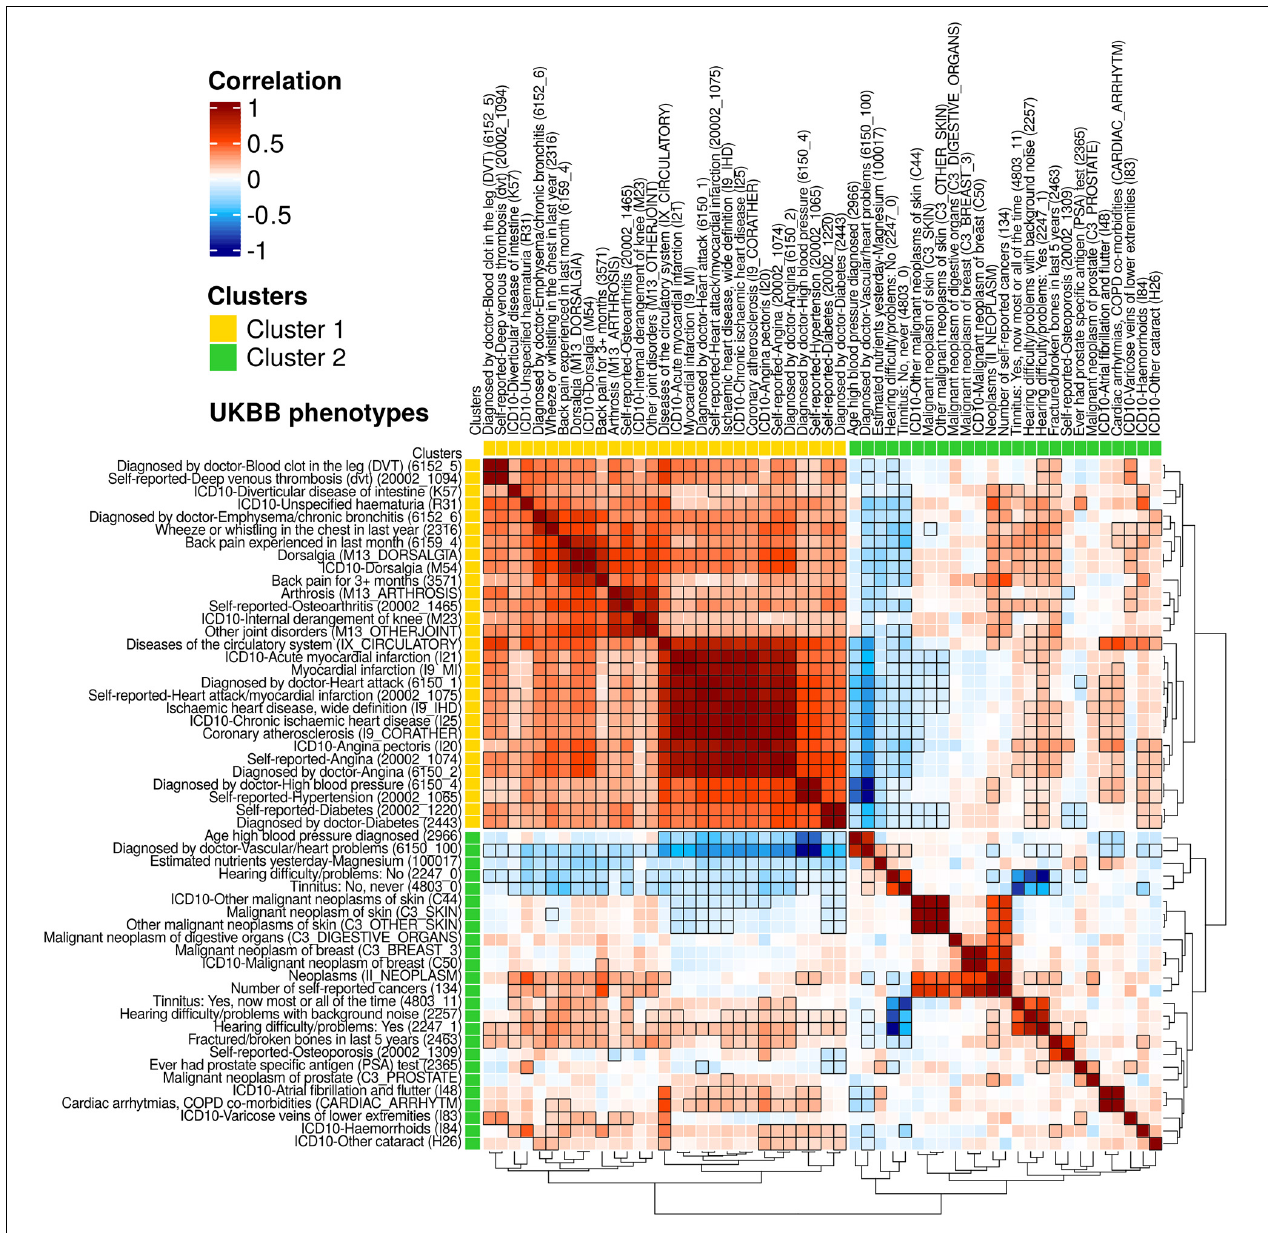
FIGURE 4 | A heatmap for genetic correlations ( r g ) of 54 UKBB phenotypes. From the publicly available UKBB genetic correlation data (https://ukbb-rg.hail.is/rg_browser/), the genetic correlations ( r g ) of 54 UKBB phenotypes are displayed. By hierarchical clustering with the dynamic tree cut algorithm, 2 clusters of phenotypes were identified; Cluster 1 is composed of 17 phenotypes with positive correlations; cluster 2 includes 26 phenotypes with both positive and negative correlations. Unique ID of the UKBB phenotypes is noted in parentheses. Colors represent the values of genetic correlations ( r g ); dark red is r g = 1, white is r g = 0, and dark blue is r g = − 1. Significant genetic correlation pairs (FDR < 0.05) are indicated with black edged